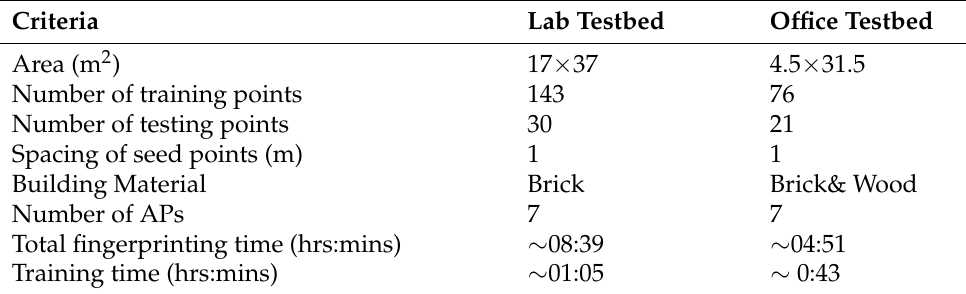
Figure 6. Layout of the Office testbed. Table 2. Summary of the testbeds considered in evaluating RRLoc